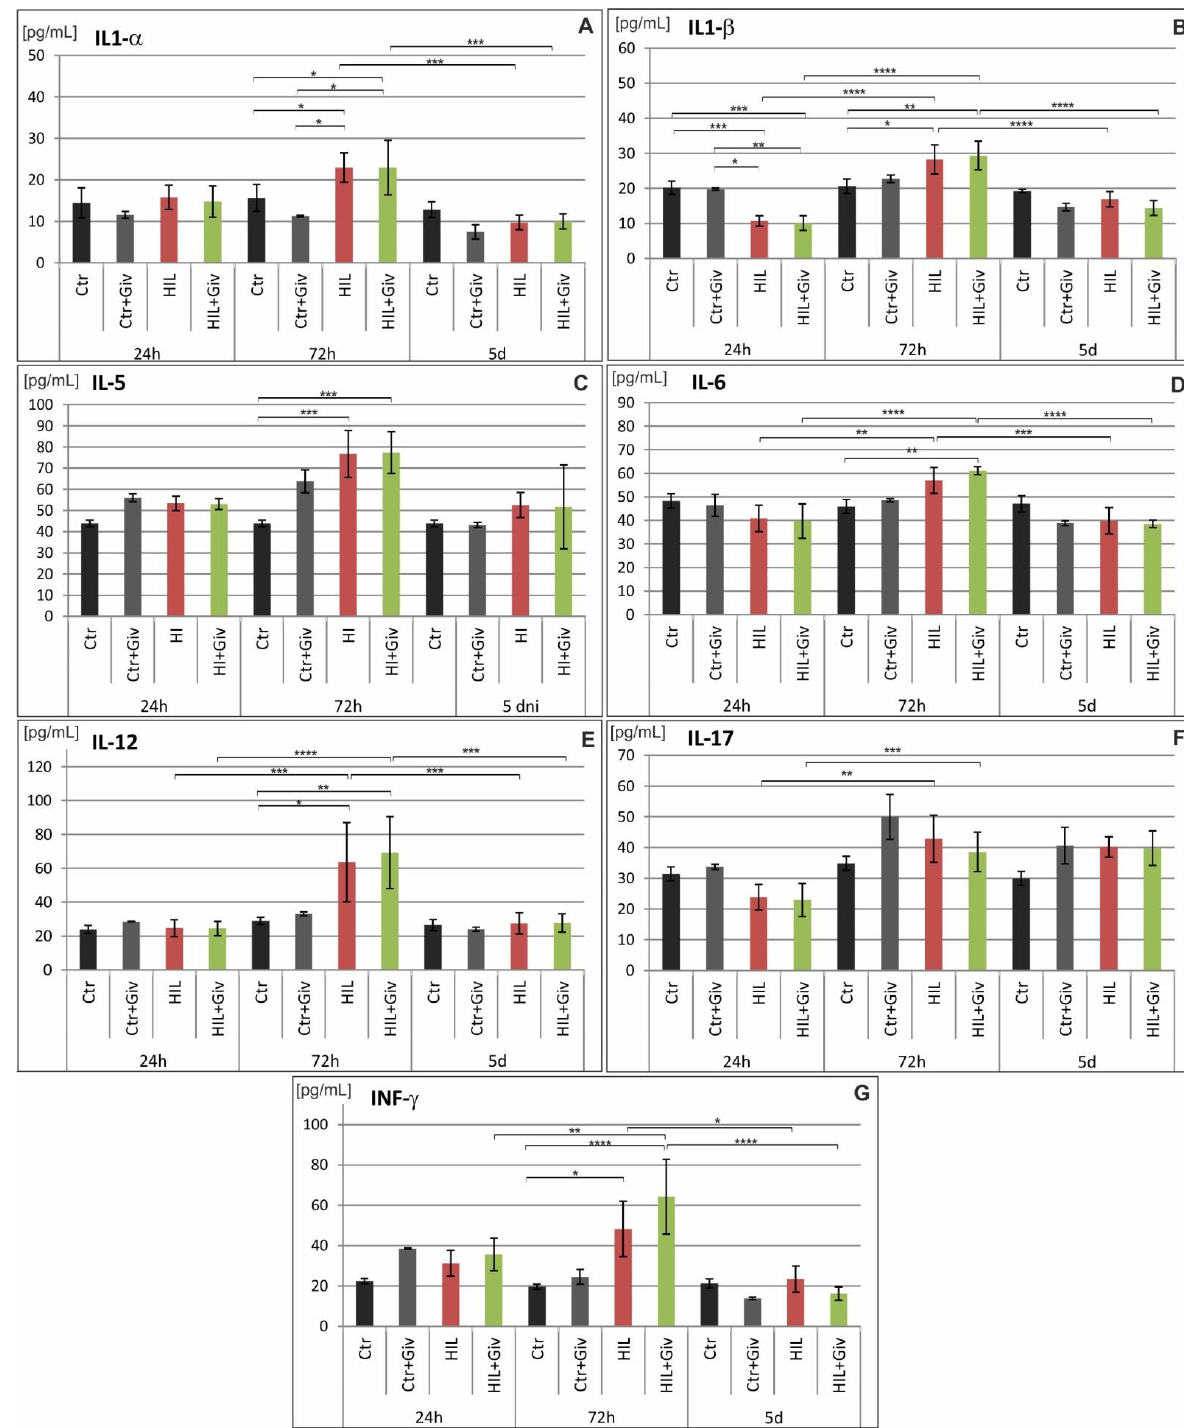
Figure 9. Proinflammatory cytokine profile in neonatal rat brains after hypoxia-ischemia. Quan- titation of IL-1 α ( A ), IL-1 β ( B ), IL-5 ( C ), IL-6 ( D ), IL-12 ( E ), IL-17 ( F ) and IFN- γ ( G ) protein levels detected in the brains of control animals and 24 h, 72 h and 5 days after hypoxia-ischemia with or without Givinostat treatment. Note the elevated level of presented cytokines 72 h after HI regardless of Givinostat administration. The values are the mean ± SD from five animals per group and time point. One-way ANOVA indicates significant differences between the investigated experimental groups: * p < 0.05; ** p < 0.01; *** p < 0.001; **** p <